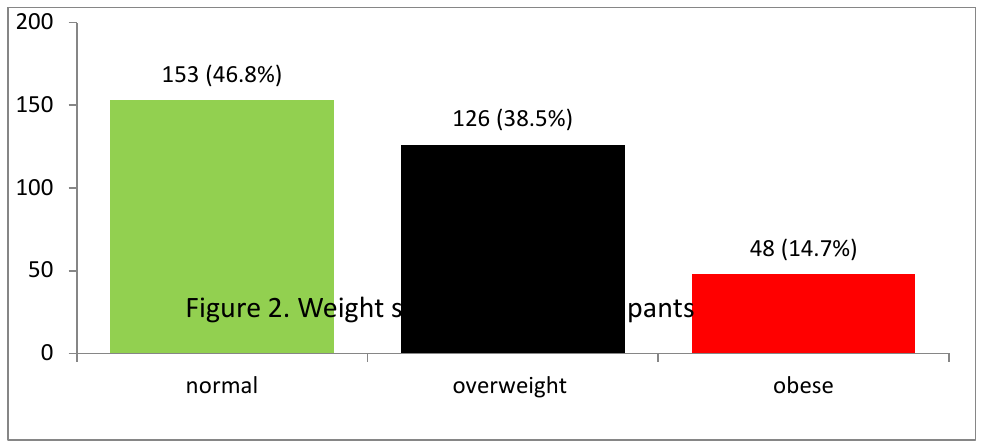
Figure 2. Weight status of the participants